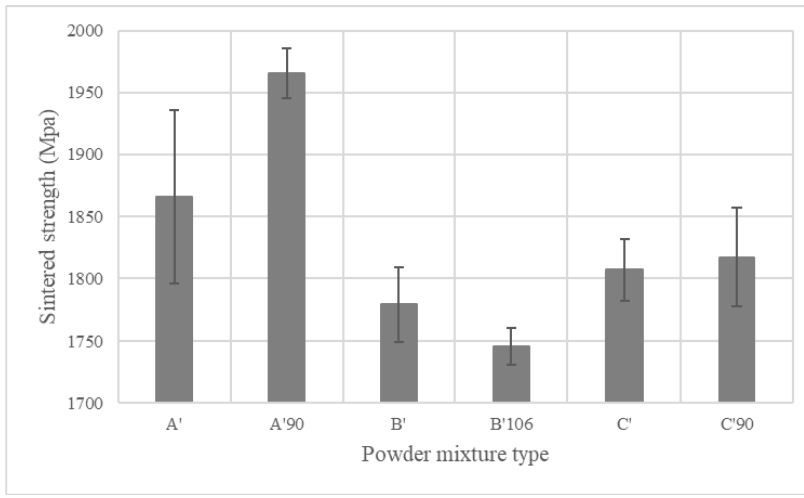
Figure 16. Sintered strength of standard TRS samples prepared from various PMS mixtures (including 0.7 wt. % of a lubricant).